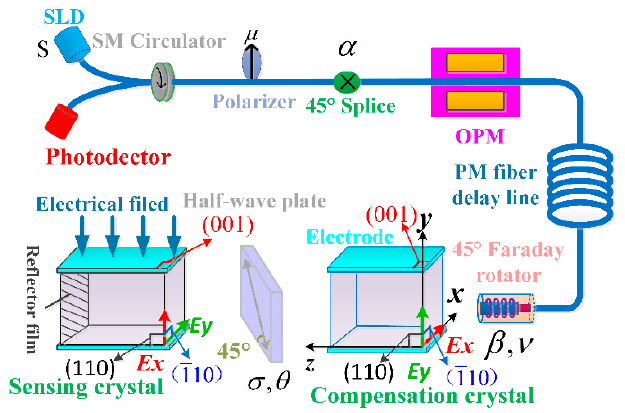
Figure 1. Configuration of optical voltage sensors (OVS) with dual-crystal scheme.